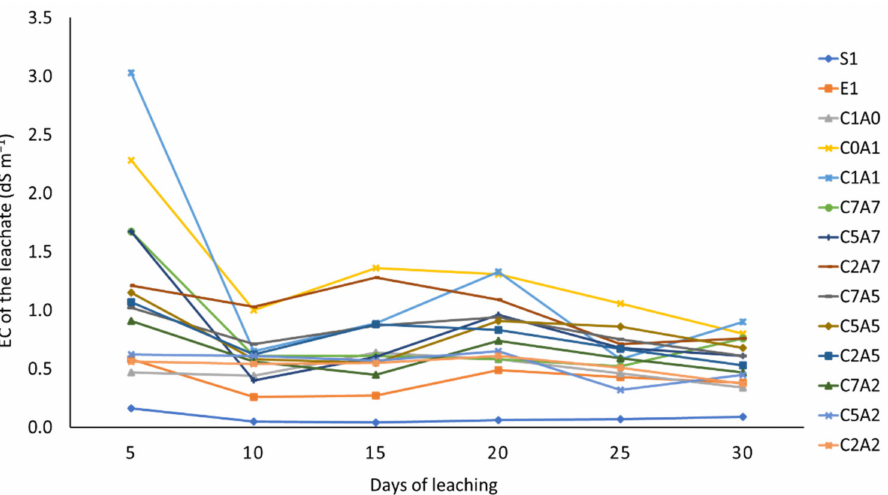
Figure 3. Treatments on electrical conductivity of leachate over thirty days of leaching, where S1: soil only; E1: soil with ERP only; C1: 100% charcoal; C0: 0% charcoal; C7: 75% charcoal; C5: 50% charcoal; C2: 25% charcoal; A1: 100% sago bark ash; A0: 0% sago bark ash; A7: 75% sago bark ash; A5: 50% sago bark ash; A2: 25% sago bark